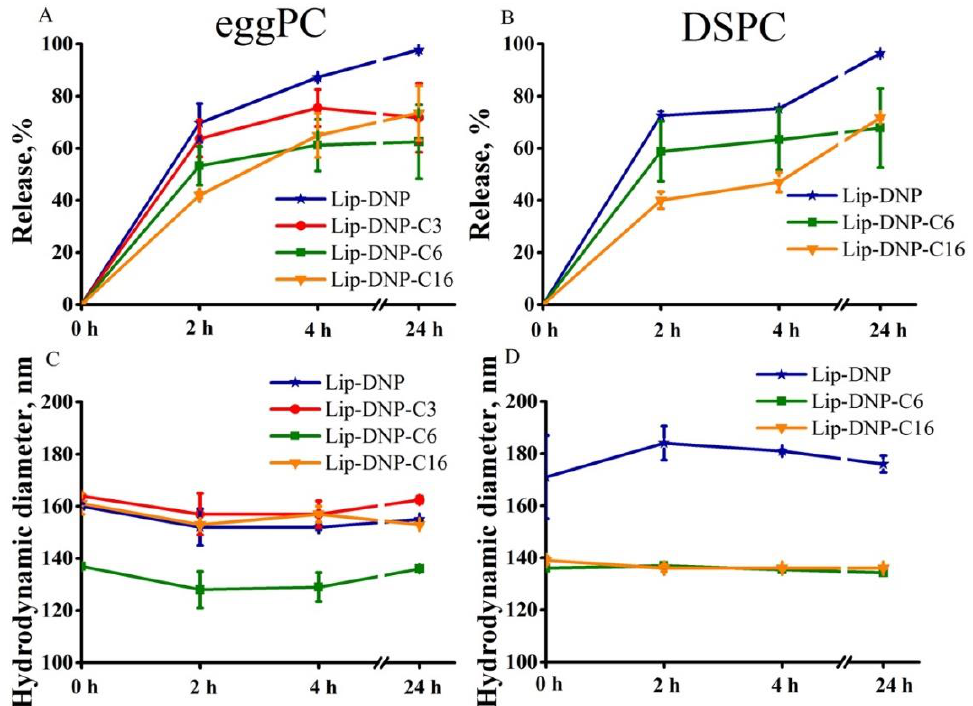
Figure 4. Release profiles of 2,4-DNP (compound 1 ), 2,4-DNP-C16 (compound 2 ), 2,4-DNP-C6 (compound 3 ), and 2,4-DNP-C3 (compound 4 ) from liposomes composed of ( A ) eggPC/DSPE-PEG- OMe (95/5 molar ratio) and ( B ) DSPC/DSPE-PEG-OMe (95/5 molar ratio) lipids upon storage in 10 mM PBS (pH 7.4) at 37 ◦ C. Hydrodynamic size stability of liposomes composed of ( C ) eggPC/DSPE- PEG-OMe (95/5 molar ratio) and ( D ) DSPC/DSPE-PEG-OMe (95/5 molar ratio) lipids upon storage in 10 mM PBS (pH 7.4) at 37 ◦ C. Data are presented as mean ± StD ( n =